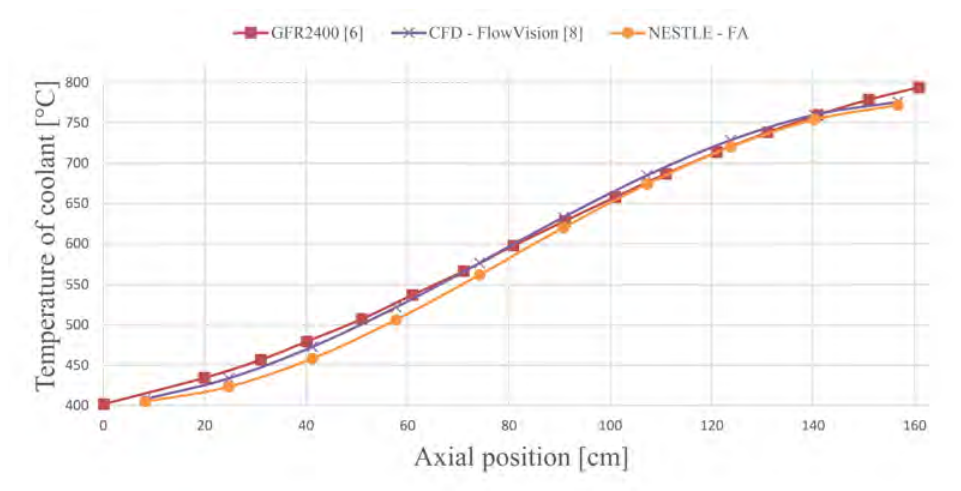
Figure 6. Results of the coolant axial temperature distribution.